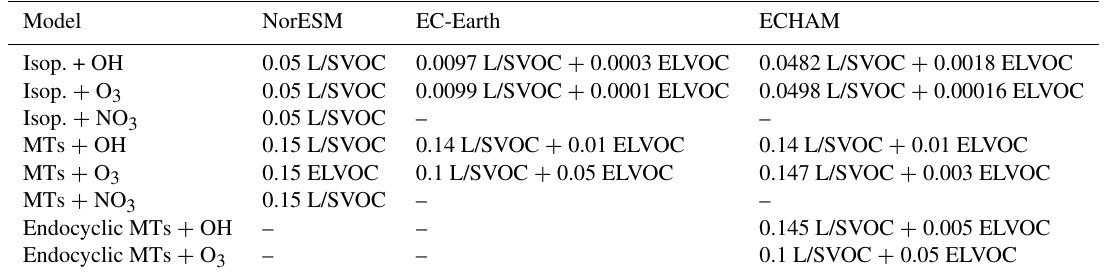
Table 2. Yields and resulting products from the reactions of BVOCs with oxidants to form ELVOC and L/SVOC for the three ESMs. In ECHAM, there are different yields for endocyclic MTs and the other MTs. The equations for the endocyclic MTs are written separately, and the other MTs are shown on the same rows as the MTs in the other